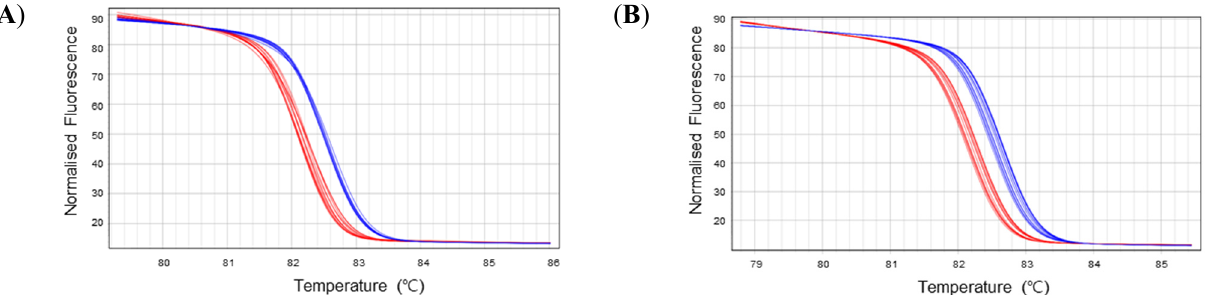
Figure 7. HRM analysis of the ‘Seeds & People’ Co. and ‘Asia Seed’ Co. onion lines. ( A ) HRM curve of the ‘Seeds & People’ Fig. 7. HRM analysis of ‘Seeds & People’ Co. and ‘Asia Seed’ Co. onion lines. (A) HRM curve of ‘Seeds & People’ Co. onion lines. Red: resistant lines (S&P 7522, S&P 7521, S&P 7129, and S&P 7168) and blue: susceptible lines (S&P 7130, Co. onion lines. Red; resistant lines (S&P 7522, S&P 7521, S&P 7129, and S&P 7168), Blue; susceptible lines (S&P S&P 7175, and S&P 7483). ( B ) HRM curve of the ‘Asia Seed’ Co. onion lines. Red: resistant lines (Asia-12, Asia-42, and 7130, S&P 7175, and S&P 7483). (B) HRM curve of ‘Asia Seed’ Co. onion lines. Red; resistant lines (Asia-12, Asia- Asia-53) and, blue: susceptible lines (Asia-30, Asia-35, Asia-45, and 42, and Asia-53), Blue; susceptible lines (Asia-30, Asia-35, Asia-45, and Asia-50).